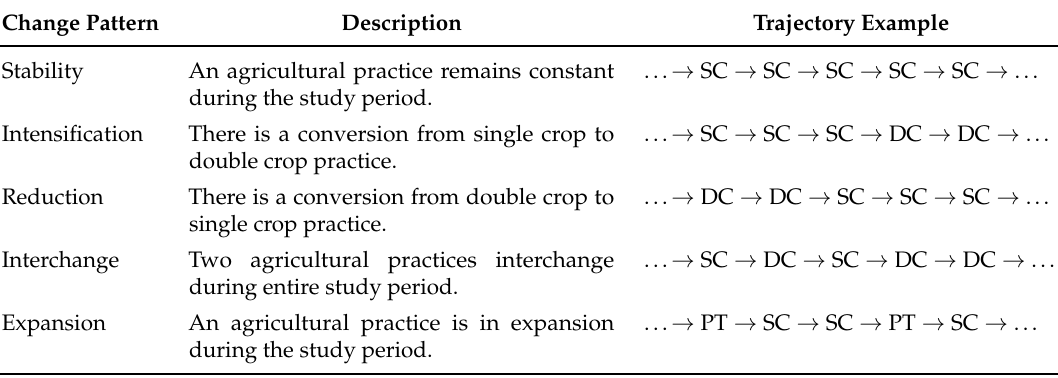
Table 1. Patterns of agricultural practices trajectories during entire study